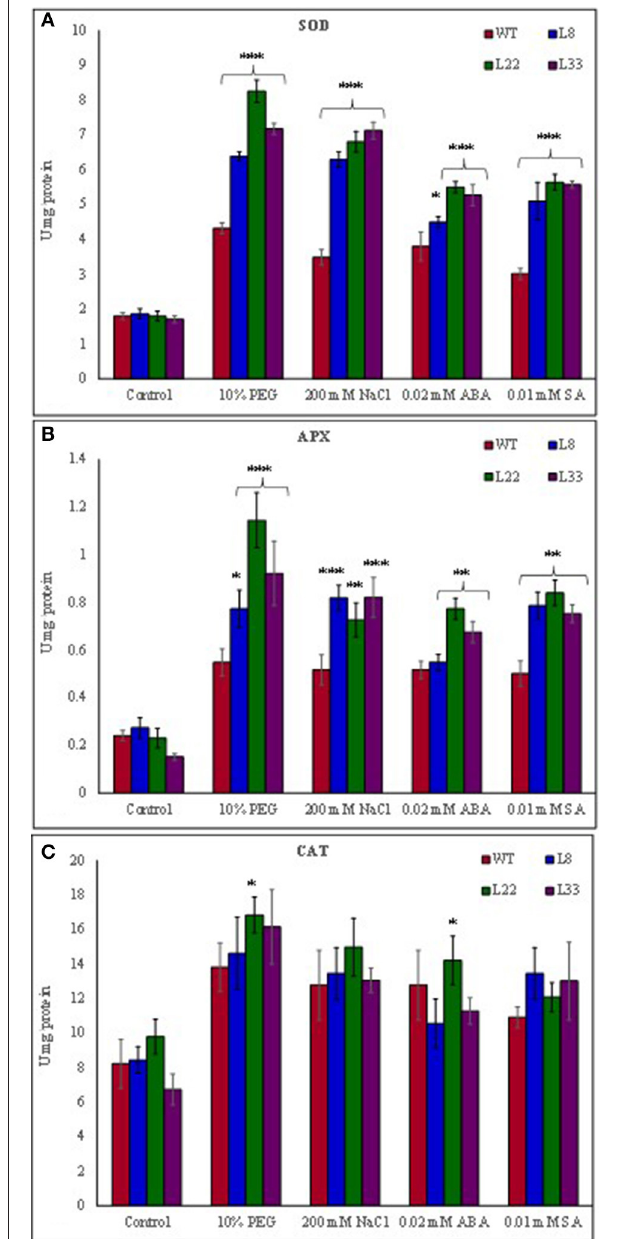
FIGURE 6 | Comparison of activity SOD (A) , APX (B) , and CAT (C) in WT and transgenic tobacco under control and stress (drought and salt) conditions. The *, **, and *** denote statistical significance in responses of transgenic lines against control at P value ≤ 0.05, 0.01, and 0.001 respectively.